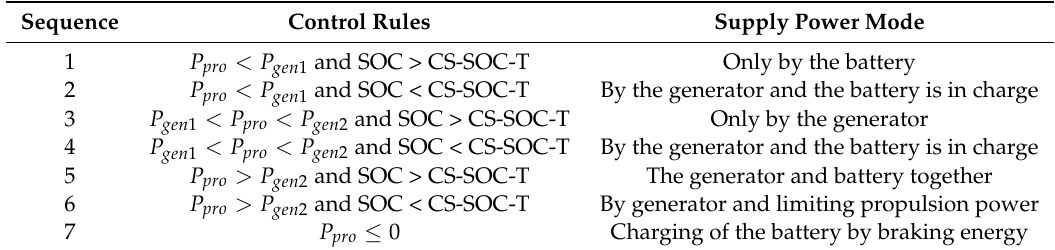
Table 5. Control strategy during the battery